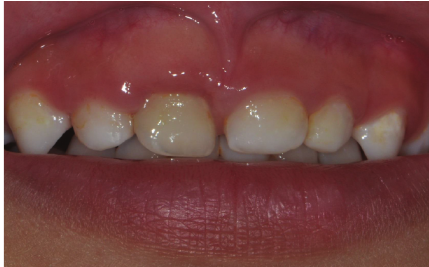
Figure 3: Clinical appearance 1 year after excisional biopsy for the gingival